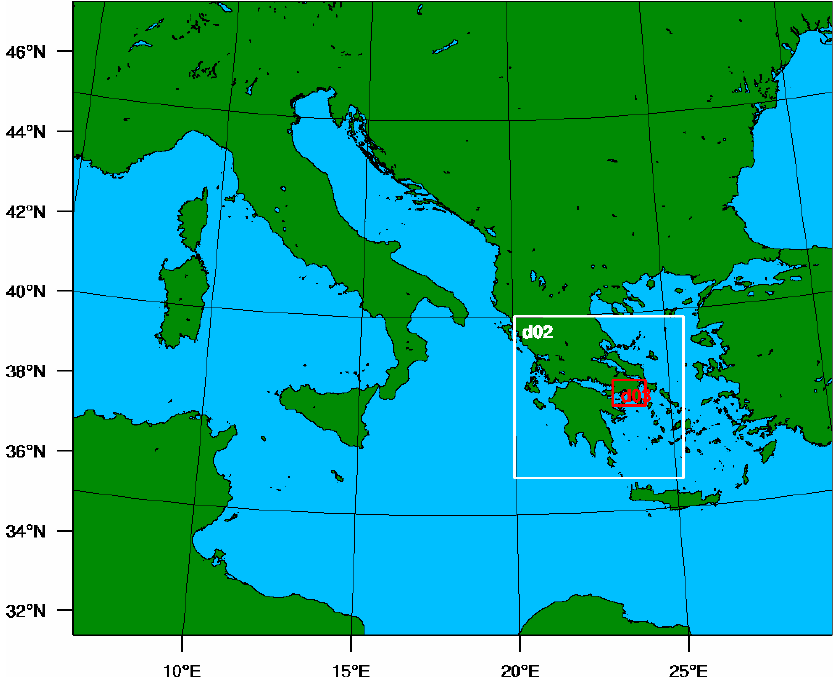
Figure 2. Nesting structure of the Weather Research and Forecasting (WRF) model setup: External domain (d01) at 12 × 12 km grid space; Intermediate domain (d02) at 3 × 3 km grid space; and inner domain (d03) at 1 × 1 km grid space.